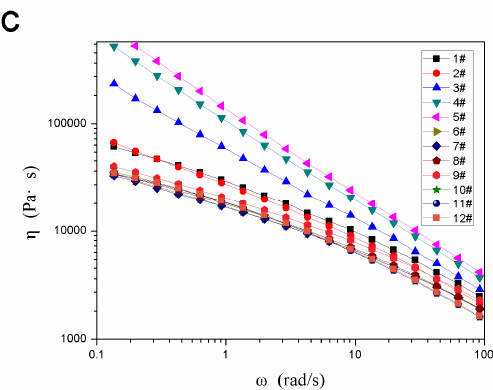
Figure 3. Rheological properties of the samples with different polymer blends: ( a ) storage modulus (G′), ( b ) loss modulus (G′′), ( c ) complex viscosity (η).